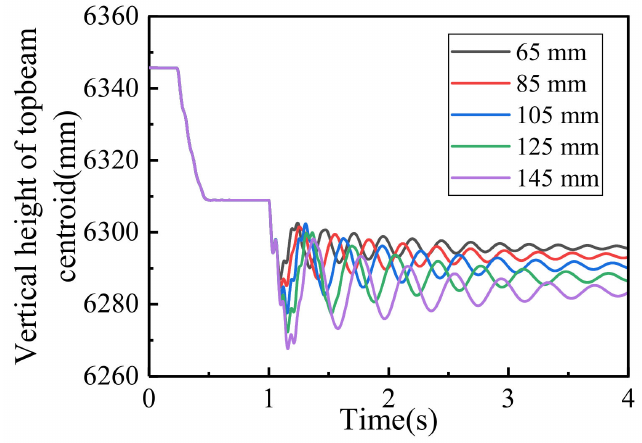
Figure 14. Displacement change in vertical direction of the centroid of top